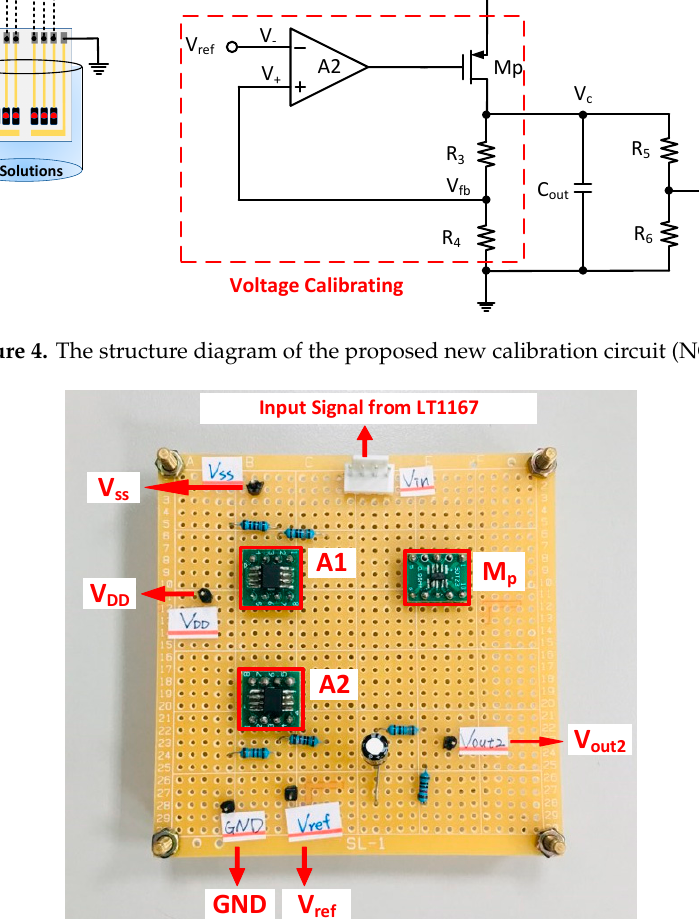
Figure 4. The structure diagram of the proposed new calibration circuit (NCC).